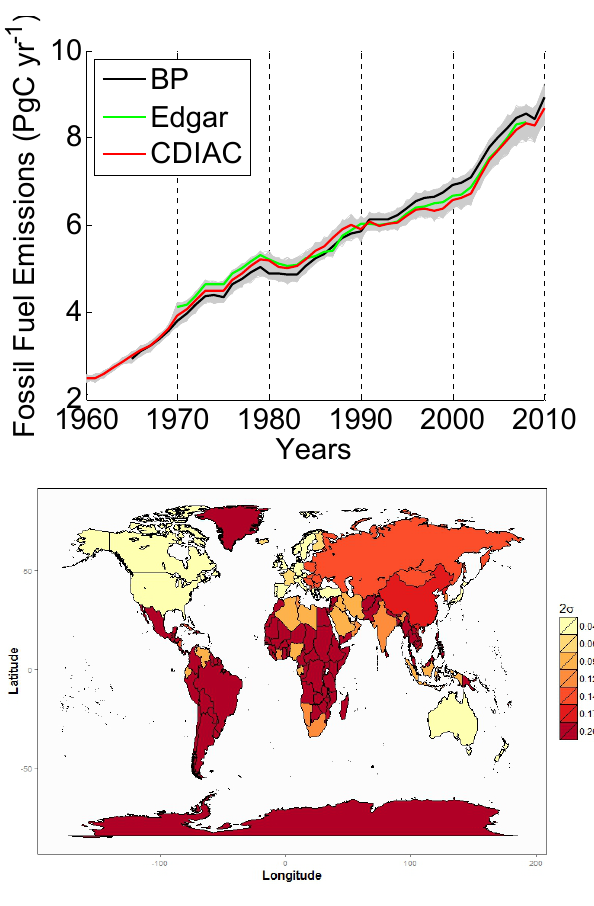
Figure 3. Fossil fuel emission estimates and their uncertainties from 1960 to 2010. The three inventories (top panel) compared are from BP (British Petroleum; black), the Emission Database for Global Atmospheric Research (EDGAR: green), and the Carbon Dioxide Information and Analysis Center (CDIAC; red). All inventories also include cement production. Thin grey traces represent the Monte Carlo simulations of uncertainty for the fossil fuel emission inven- tories ( N = 3 × 500 = 1500). Errors are estimated by deriving re- gional error distributions and then randomly drawing from these distributions for error estimates of individual nations (bottom panel) where error estimates are modified from Andres et al. (2014). Emis- sion errors are reported as relative errors of total emissions by na- tion, and emission errors for Antarctica are for the Antarctic fishing fleet. See Supplement, Table 1, for national